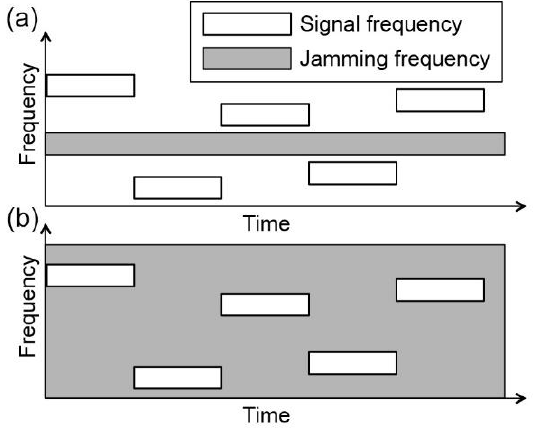
Figure 1. A comparison between ( a ) narrow band jamming ( b ) wide band jamming.